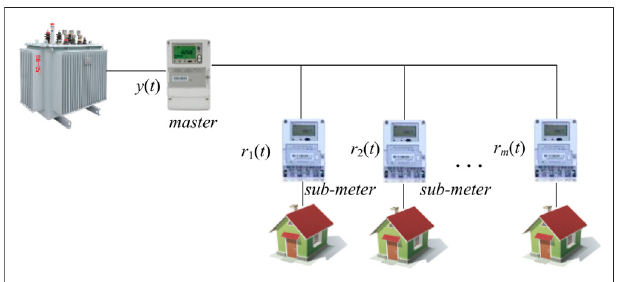
FIGURE 1 | The distribution of smart meters in the electric